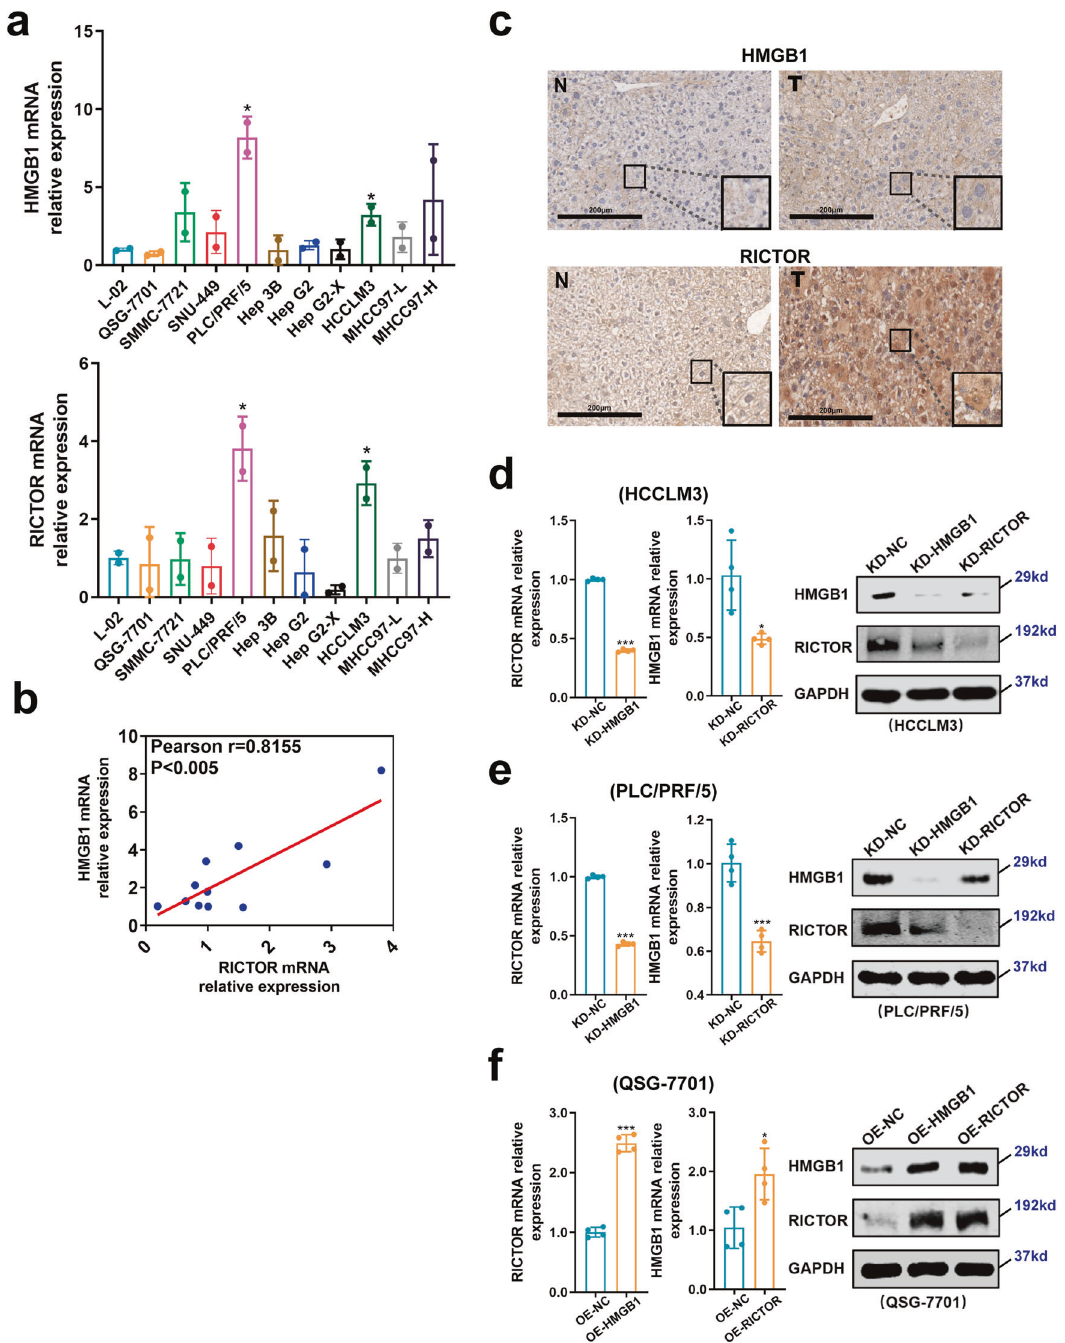
Fig. 2 HMGB1 epigenetically regulates the expression level of RICTOR in HCC. a The mRNA expression of HMGB1 and RICTOR in the 11 indicated cell lines as determined by qRT-PCR. * p < 0.05. b Pearson correlation coef fi cient analysis between the expression level of HMGB1 and RICTOR in the cell lines from ( a ). c Immunohistochemical staining of HMGB1 and RICTOR in liver tissues in the DEN + CCl4-induced liver cancer mouse model. d , e The expression levels of RICTOR and HMGB1 mRNA (left) and protein (right) after the interference of HMGB1 or RICTOR in the HCCLM3 ( d ) and PLC/PRF/5 ( e ) cell lines (abbreviated as “ KD-HMGB1 or KD-RICTOR ” , respectively). f The expression levels of RICTOR and HMGB1 mRNA (left) and protein (right) after overexpression of HMGB1 or RICTOR 3 ′ UTR in the QSG-7701 cell line (abbreviated as “ OE-HMGB1 or OE-RICTOR ” , respectively). The mRNA levels (left) were determined by qRT-PCR and protein level (right) was determined by Western blot. * p < 0.05, *** p < inhibition of C-MYC, GS, or GDH in HCC cell lines led to a signi fi cant blockage of malignant cell proliferation, while the downregulation of SIRT4 promoted HCC cell growth (Supplemen- tary Fig. 5b). It is indicated the tumor-promoting effect of C-MYC, GS, and GDH and tumor-inhibiting function of SIRT4.